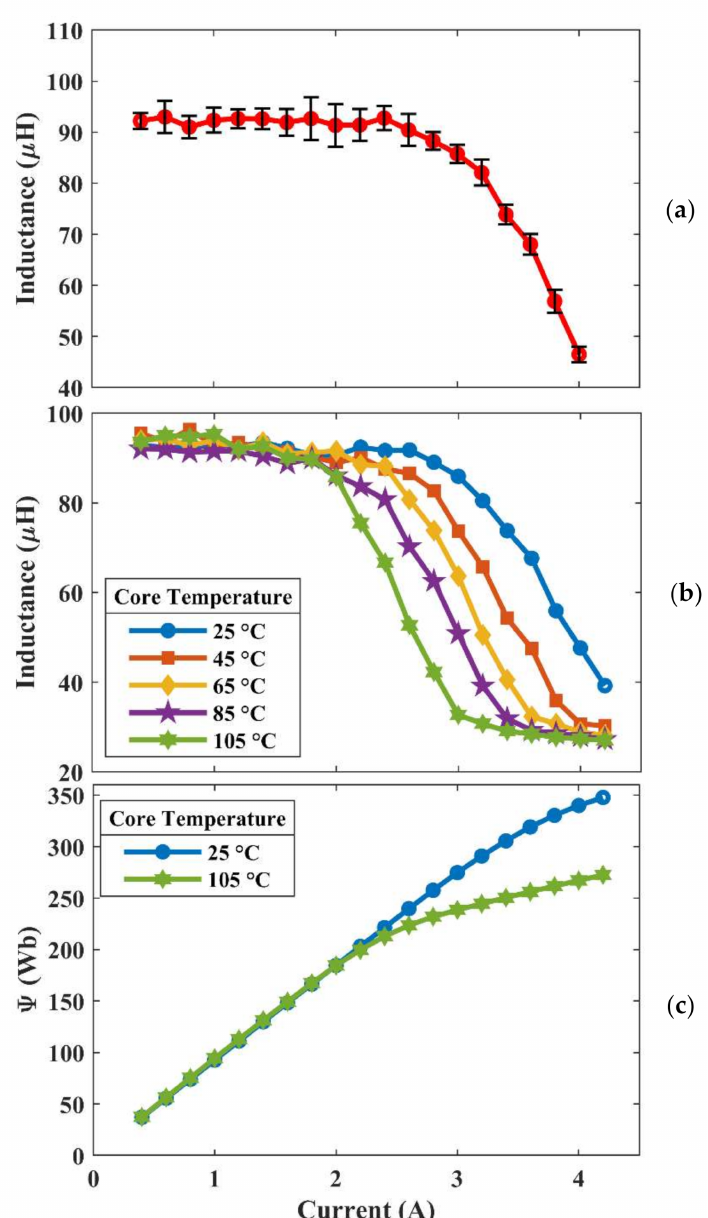
Figure 4. Inductor 1 characteristics as a function of current and temperature: ( a ) inductance vs. current at T core = 25 ◦ C with error band representing the 95% confidence interval; ( b ) inductance vs. current; ( c ) flux curve vs.